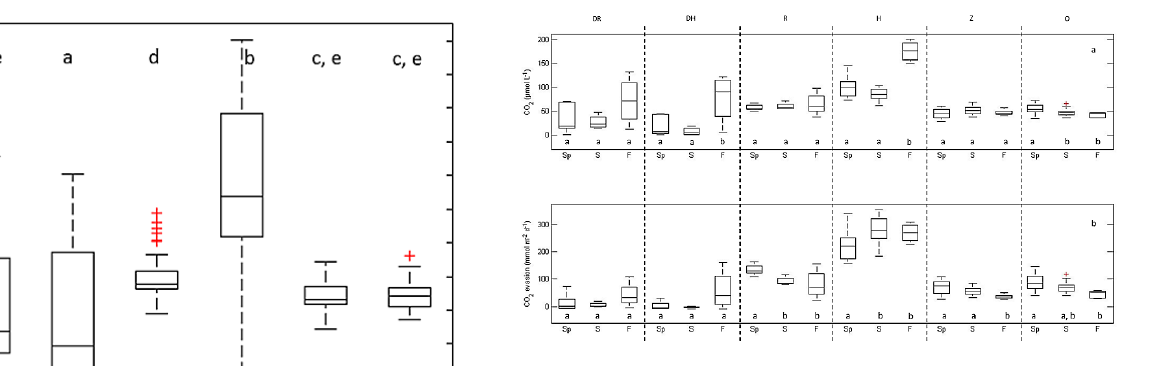
Fig. 4. Boxplots describing the annual fluctuation of CO 2 concen- trations (a) and evasion (b) from streams Rappbode (R), Hassel (H), Zillierbach (Z) and Ochsenbach (O) and the pre-dams Rappbode (DR) and Hassel (DH). Seasons are abbreviated as follows: Sp is spring, S is summer and F is fall. Significant differences between groups are indicated by letters a and